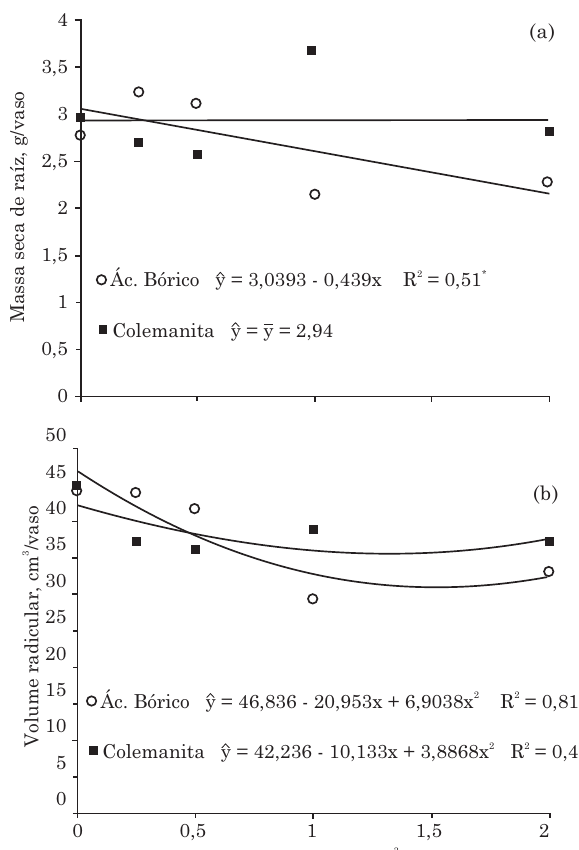
Figura 3. Produção de matéria seca de raiz (a) e volume radicular (b) de plantas de soja em função da interação significativa entre fontes e doses de B aplicadas ao